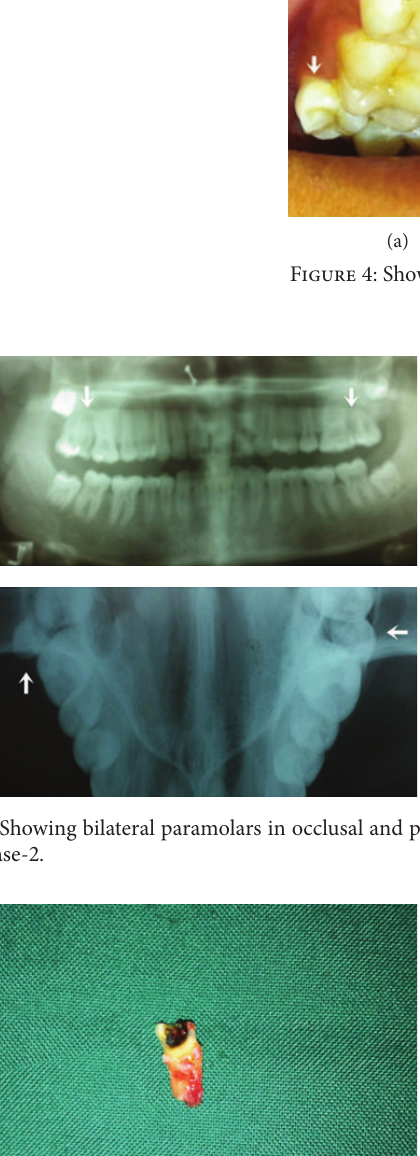
mesiodens, paramolars, distomolars, and parapremolar and according to orientation it can be vertical, inverted, and transverse [3,